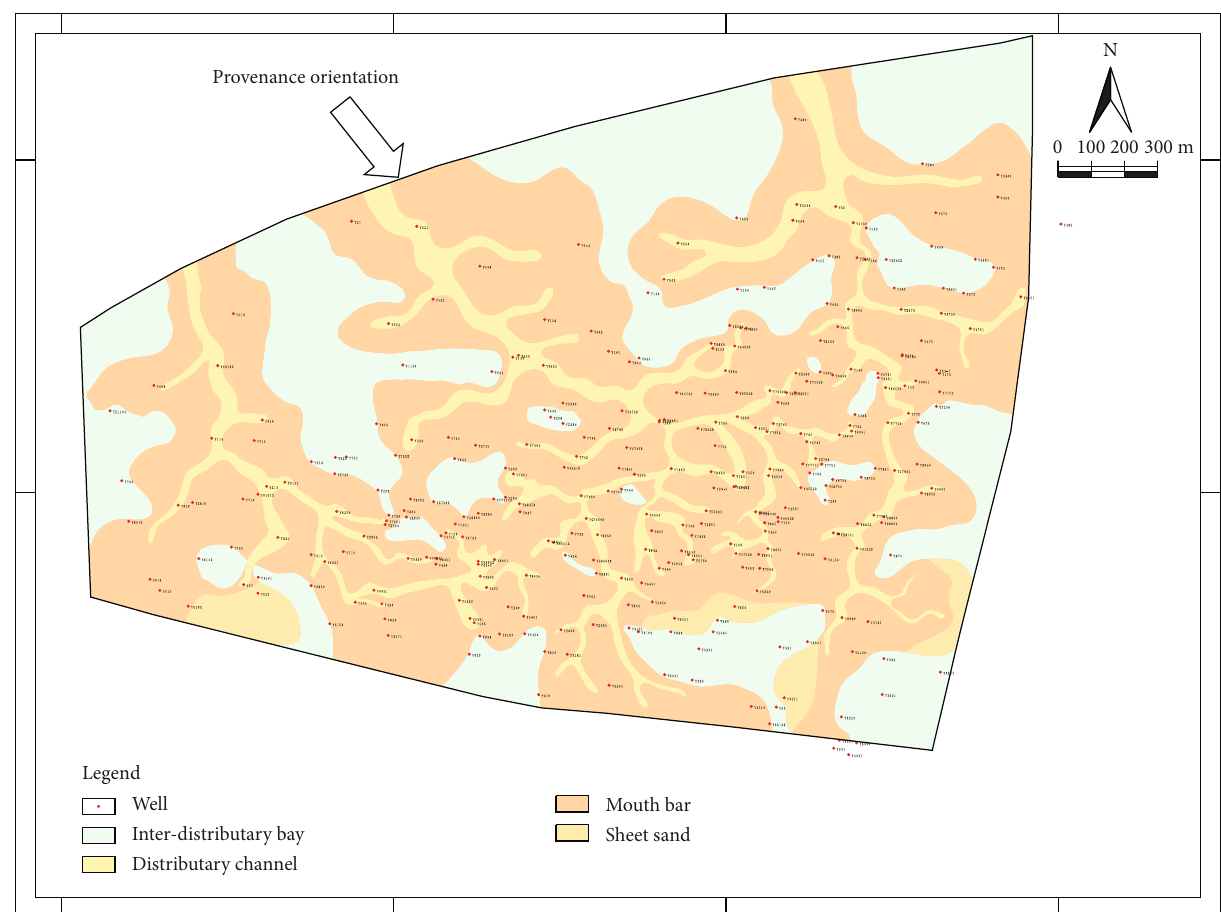
Figure 2: Map of sedimentary microfacies of VII-15 members of N 21 reservoir in Gasikule Oil fi eld.